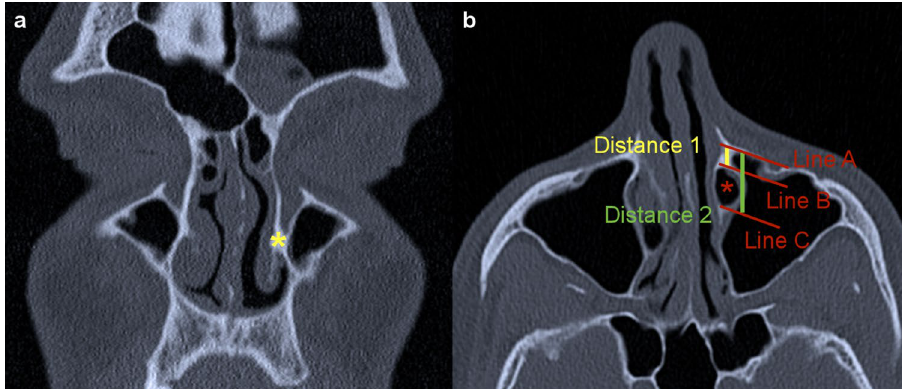
Figure 1. Methodology of measurements. ( a ) The yellow asterisk marks the anterior insertion point of the inferior turbinate into the frontal process of the maxilla, determined in the coronal CT plane. ( b ) The yellow line displays the distance between the anterior maxillary sinus wall and the anterior border of the nasolacrimal duct (Distance 1). The difference between distance 1 and distance 2 (green line) represents the width of the nasolacrimal duct (red asterisk). ( b ) Depicts the corresponding axial CT image to figure